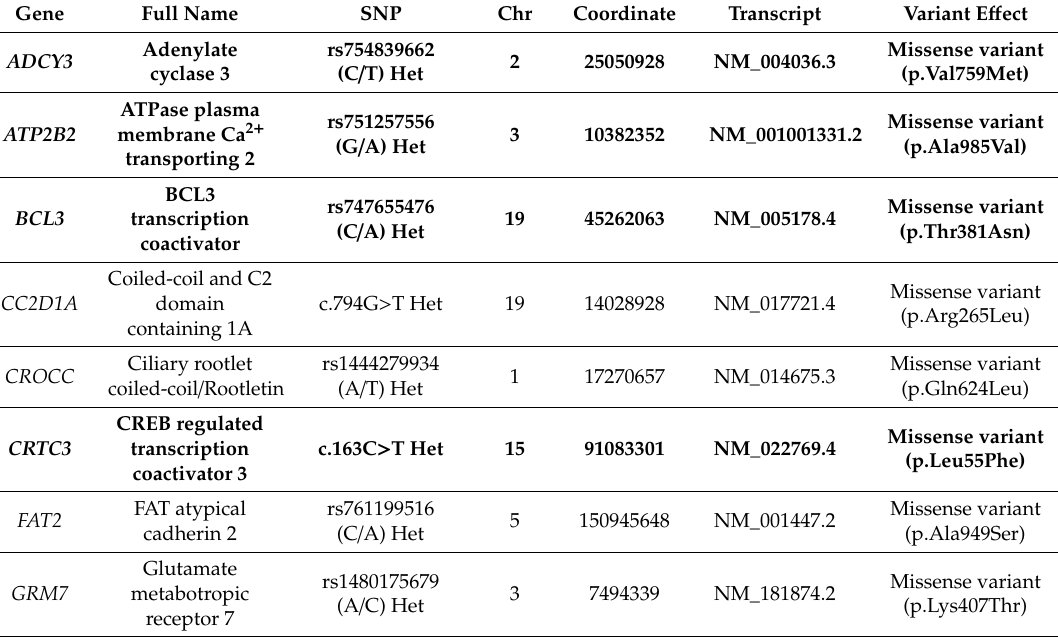
Table 3. List of DNA missense variants of interest found in patient 1 and 2.